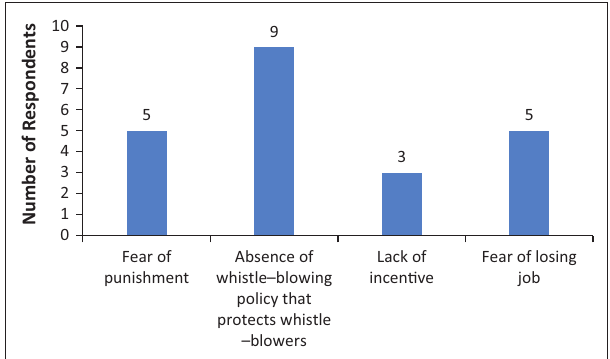
FIGURE 2: Factors impeding